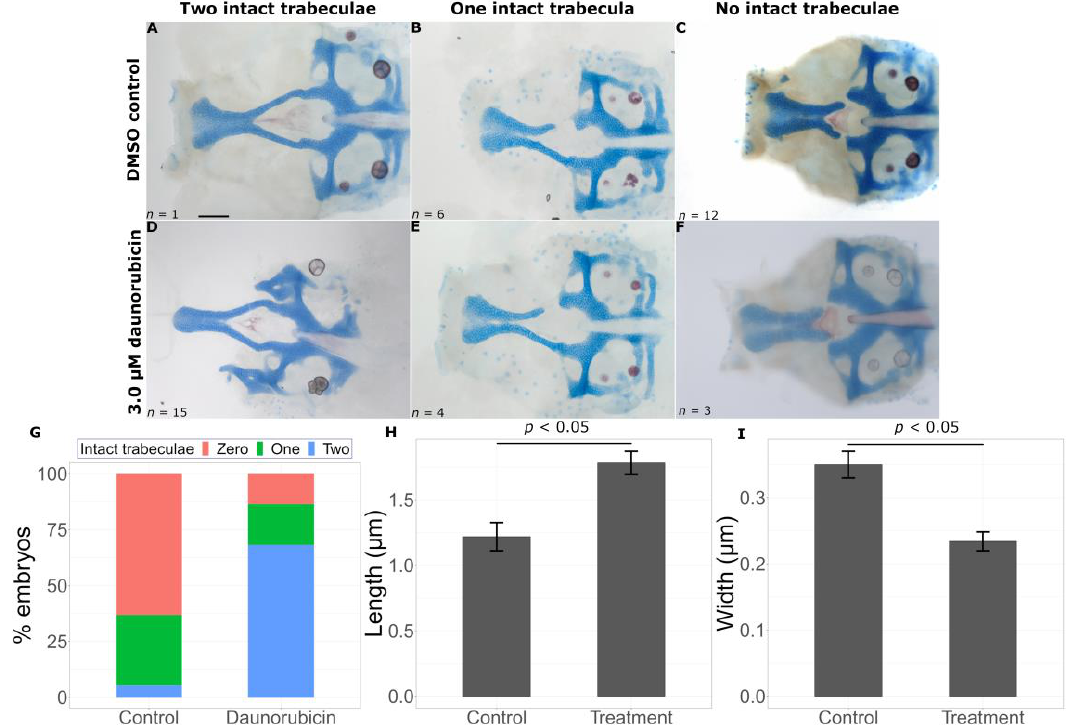
Figure 8. Daunorubicin suppresses the gata3 mutant phenotype. Representative flat mounts show breaks in the trabeculae with DMSO treatment ( A – C ) and chemical treatment ( D – F ). Daunorubicin treatment leads to a statistically significant increase in intact trabeculae count (( G ), p < 0.05), an increase in trabeculae length (( H ), p < 0.05) and a decrease in trabeculae width (( I ), p < 0.05). Error bars represent SEM. Scale bar = 0.5 μm.